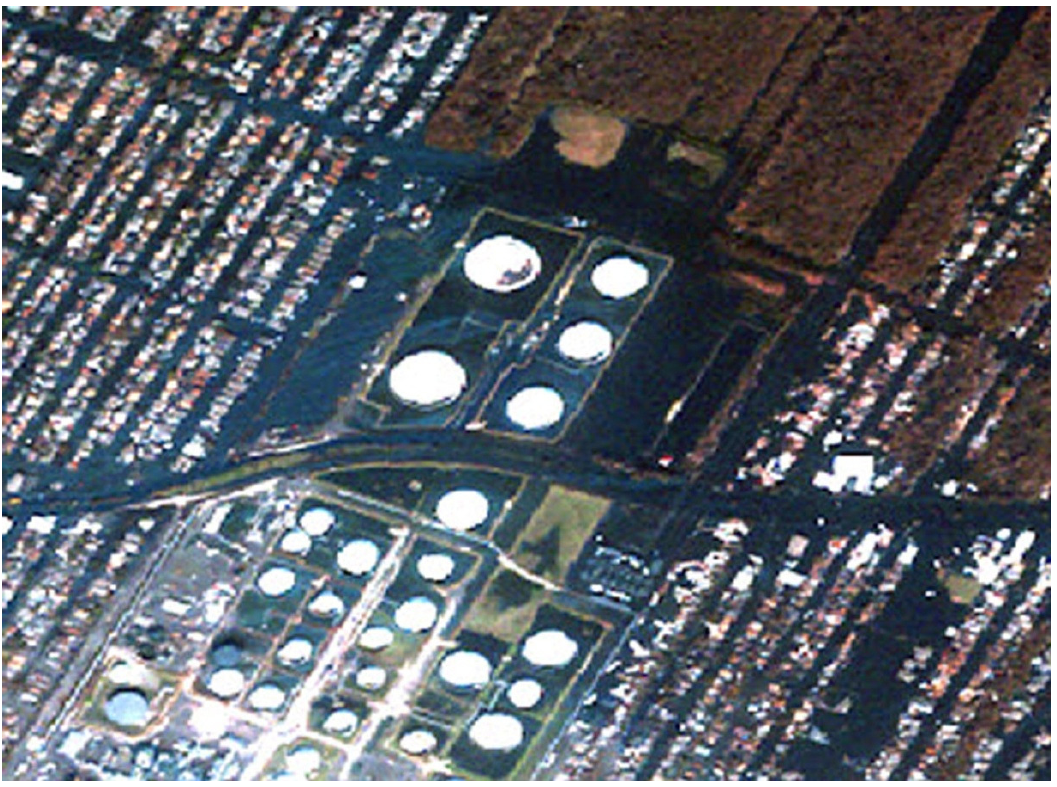
Figure 4. Oil spill from failed containment of a storage facility during Hurricane Katrina. The spill is represented by a light blue sheen on the water. Source: The EPA/Environmental Photographic Interpretation Center